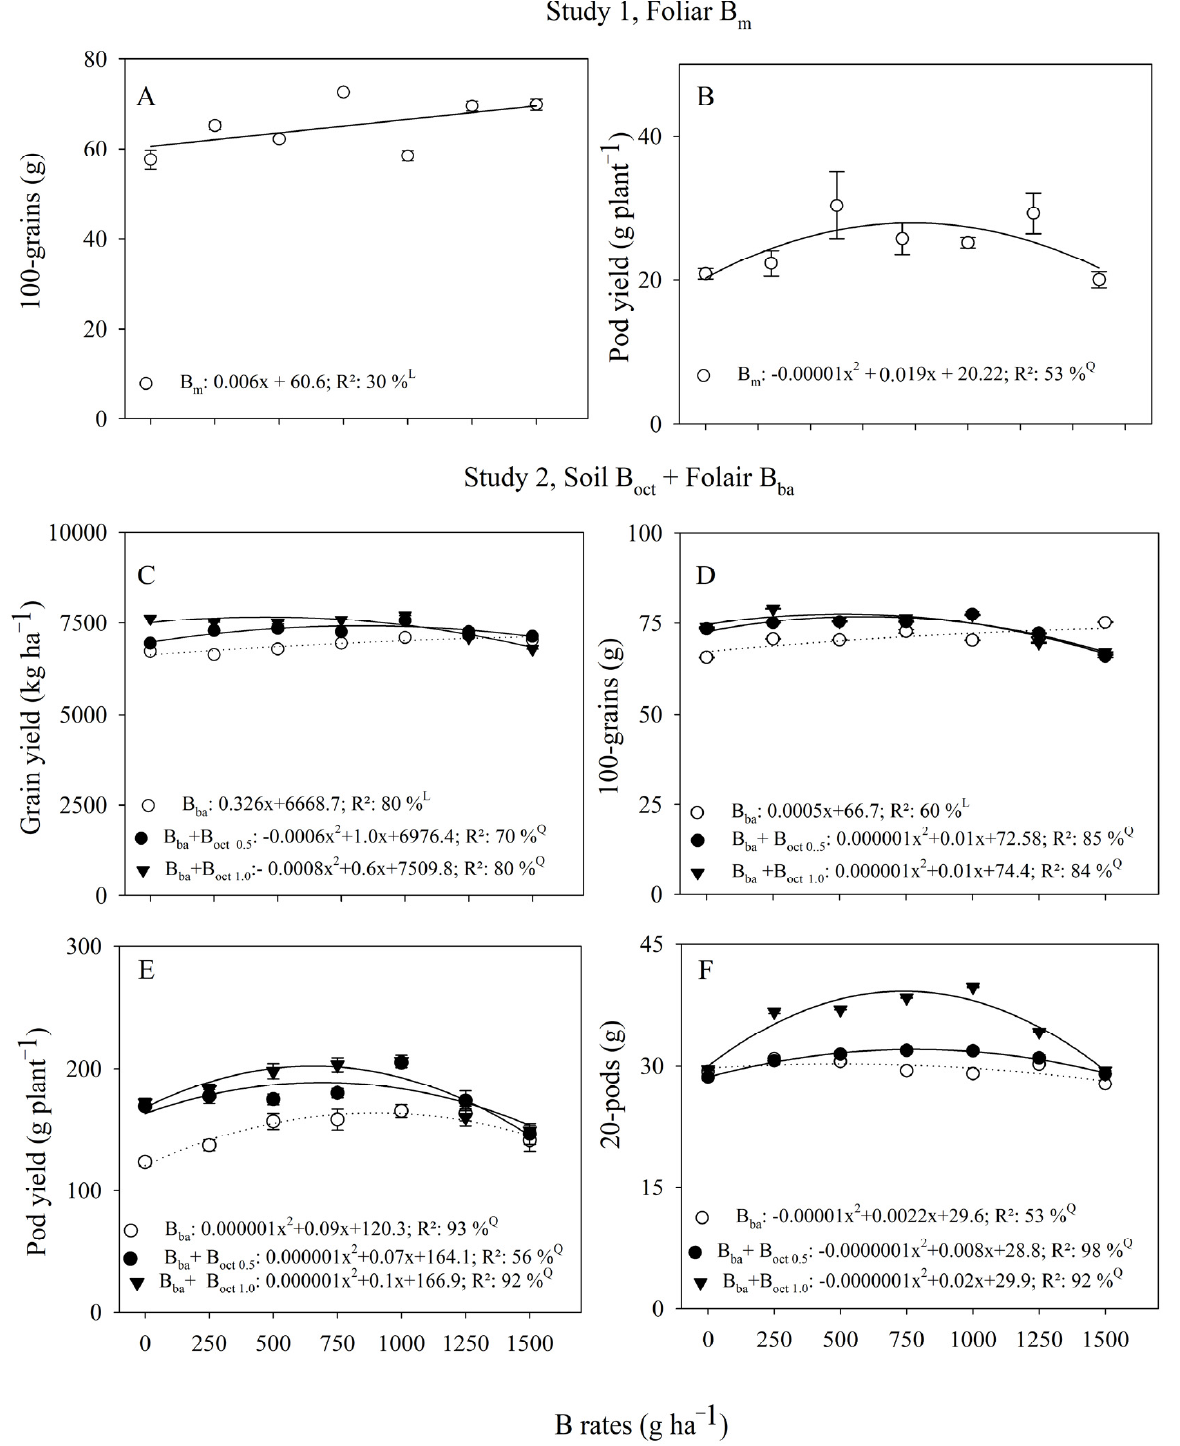
Figure 3. The 100-grains (g; ( A – D )), pod yield (g planta − 1 ; ( B – E )), grain yield (kg ha − 1 ; C ), and 20-pods (g; ( F )) in Study 1 with foliar application of B (Bm, monoethanolamine) using six B rates (250, 500, 750, 1000, 1250 and 1500 g ha − 1 ), and in Study 2 with B application in soil using sodium octaborate (Boct) with two rates (Boct0.5: 0.5 kg ha − 1 ; and Boct1.0: 1.0 kg ha − 1 ), and the foliar B application using boric acid (Bba) with six rates (250, 500, 750, 1000, 1250, and 1500 g ha − 1 ). L and Q: linear and quadratic models, respectively. Averages presented with error variation. Boct0.5 = sodium octaborate at 0.5 kg ha − 1 ; Boct1.0 = sodium octaborate at 1.0 kg ha − 1 .